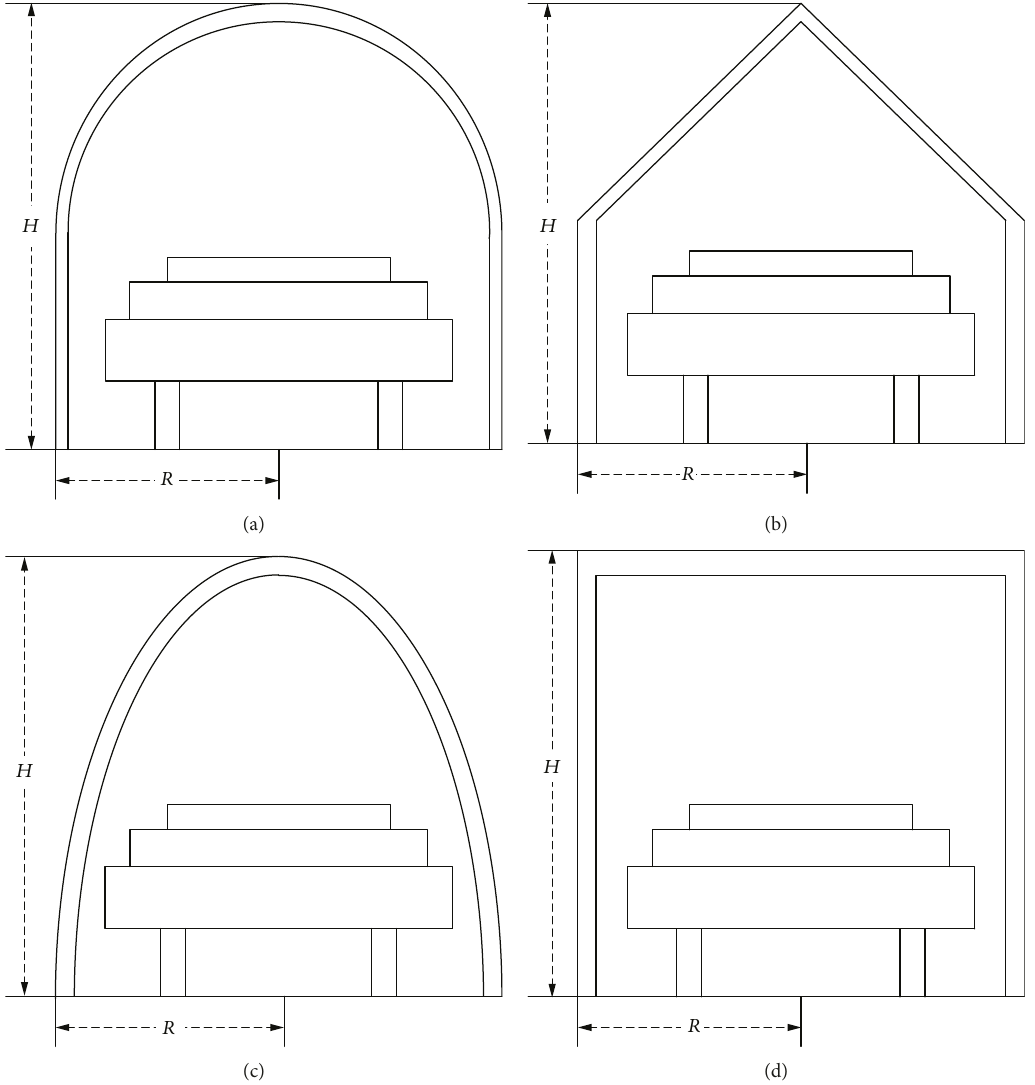
Figure 3: Di ff erent geometries of radomes: (a) hemisphere-cylinder radome, (b) cone-cylinder radome, (c) tangent-ogive radome, and (d) square